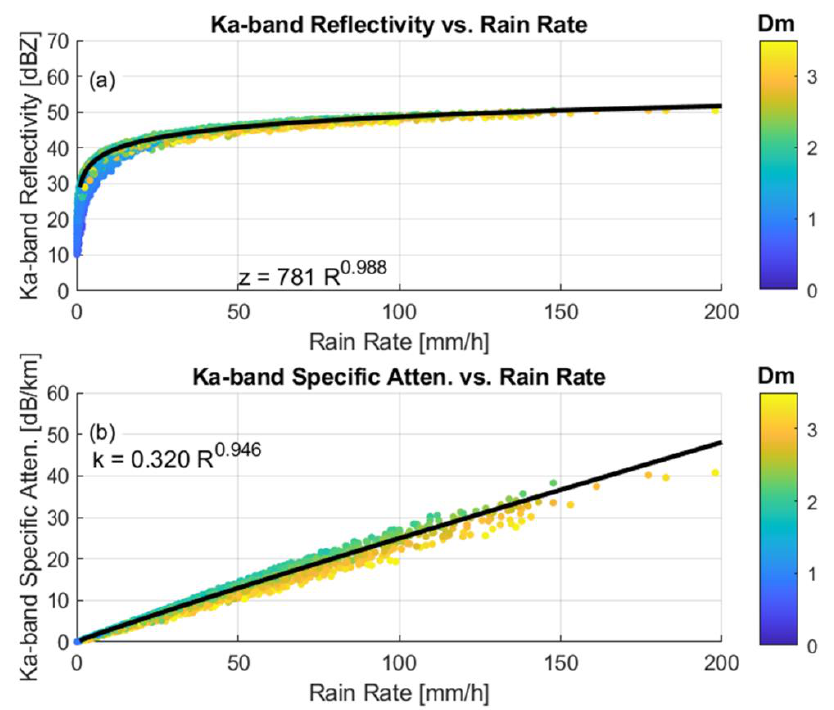
Figure 5. Relationships between surface Parsivel disdrometer derived rain rate, radar effective reflectivity factor, and rain specific attenuation. ( a ) Radar Ka-band effective reflectivity factor [dBZ] versus rain rate [mm h −1 ] with colors indicating 𝐷 𝑚 [mm]. ( b ) Radar Ka-band rain specific attenuation [dB km −1 ] versus rain rate [mm h −1 ] with colors indicating 𝐷 𝑚 [mm]. The regression lines are power-law fits of the form (6) and (7) with coefficients listed in Table 3.